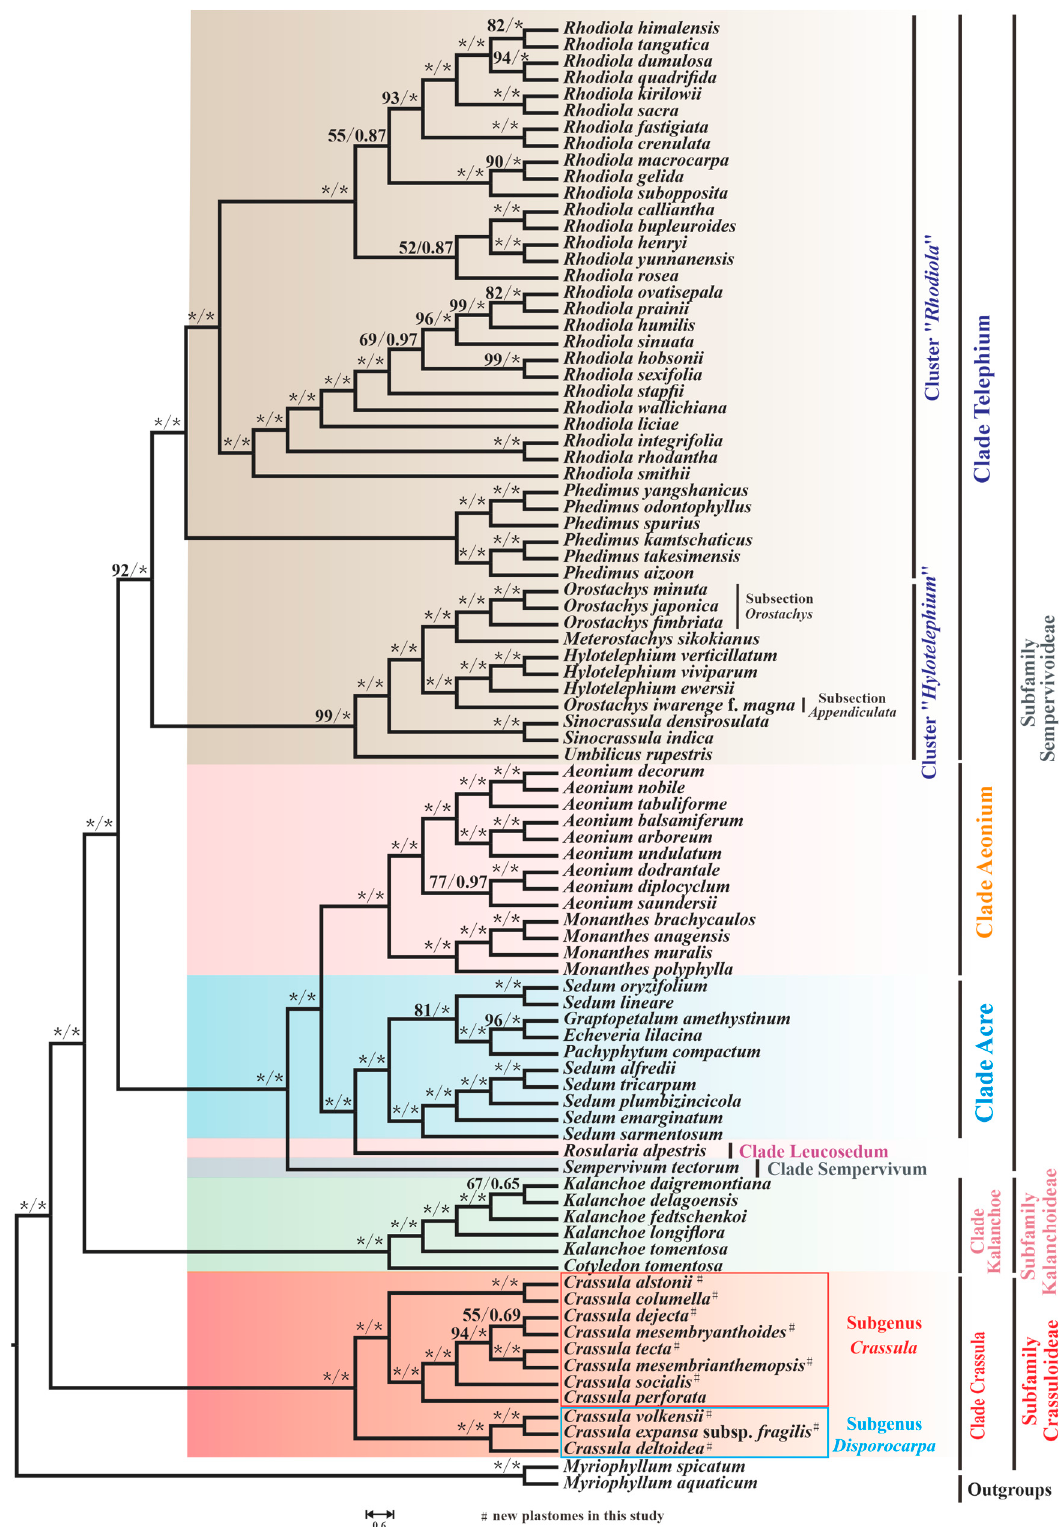
Figure 10. The phylogenetic tree of 87 Crassulaceae species based on ML and BI methods. The maximum likelihood bootstrap (BS) and Bayesian posterior probability (PP) values for each node are indicated; * indicates 100% bootstrap or 1.00 PP.